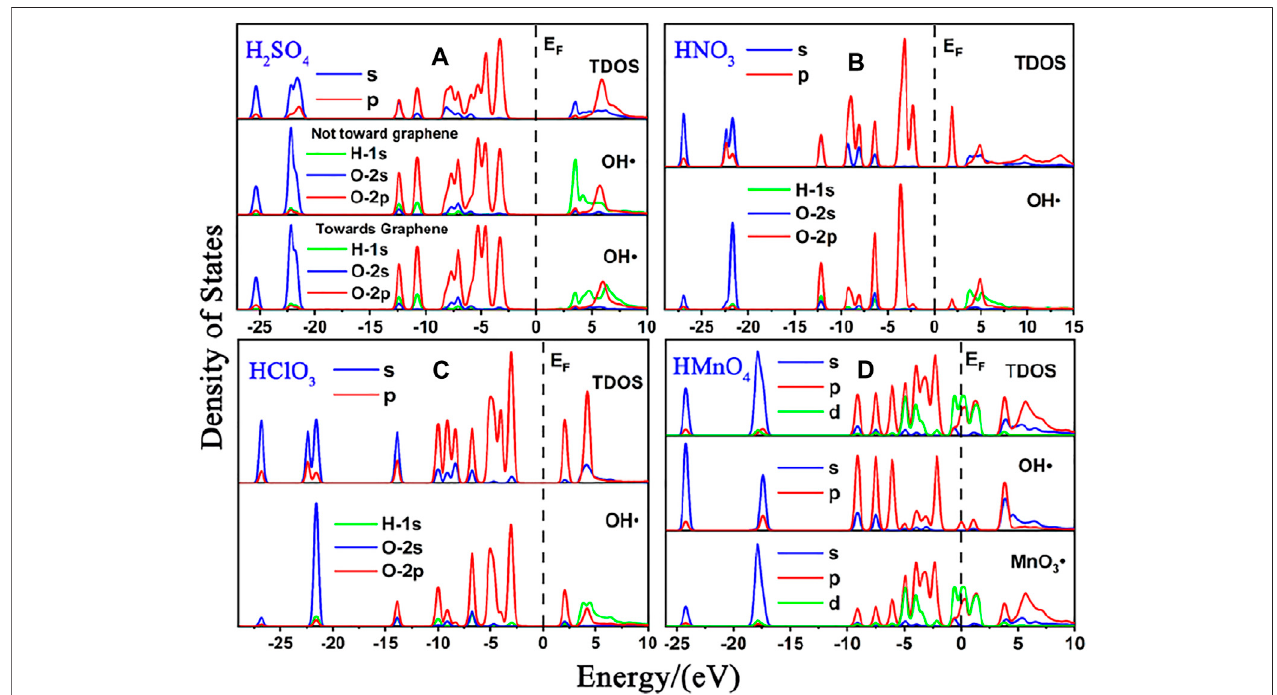
FIGURE 1 | DOS of single-component acid molecules reacting with the non-defective graphene in the absence of water. (A) , (B) , (C) , and (D) are the DOS of H 2 SO 4 , HNO 3 , HClO 3 and HMnO 4 , respectively. In each diagram, the top represents the total density of states (TDOS), and the bottom represents the local density of (cid:129) (cid:129) states (LDOS) of OH . Particularly, there is also the LDOS of MnO 3 at the bottom of (D) .